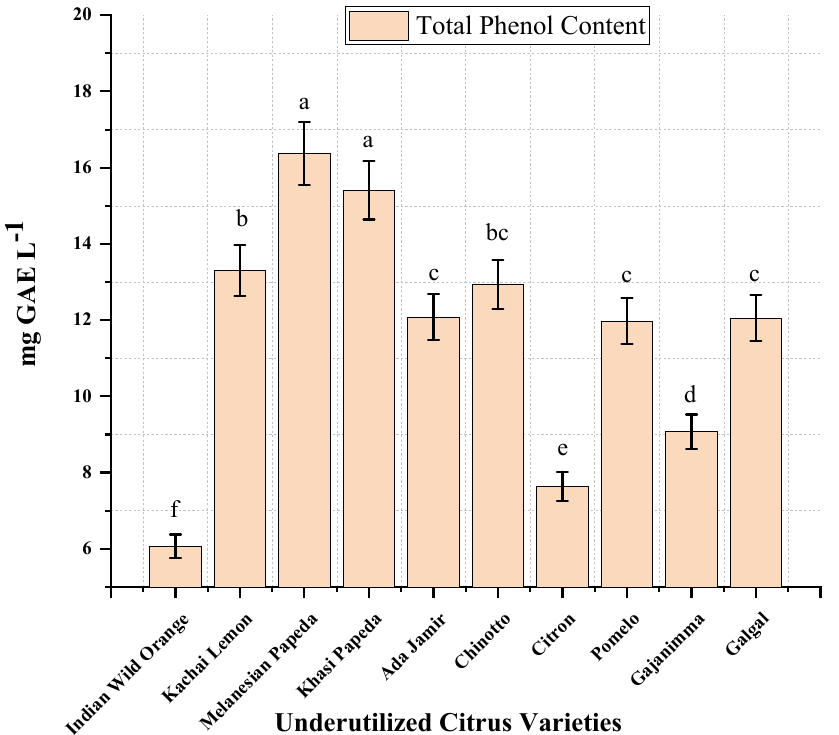
Figure 1. Total phenol compound content in underutilized citrus varieties. Significant ANOVA p < 0.01. Letters a to f above mean (n = 3) bars denote significant differences at p < 0.01 according to Tukey’s HSD test.